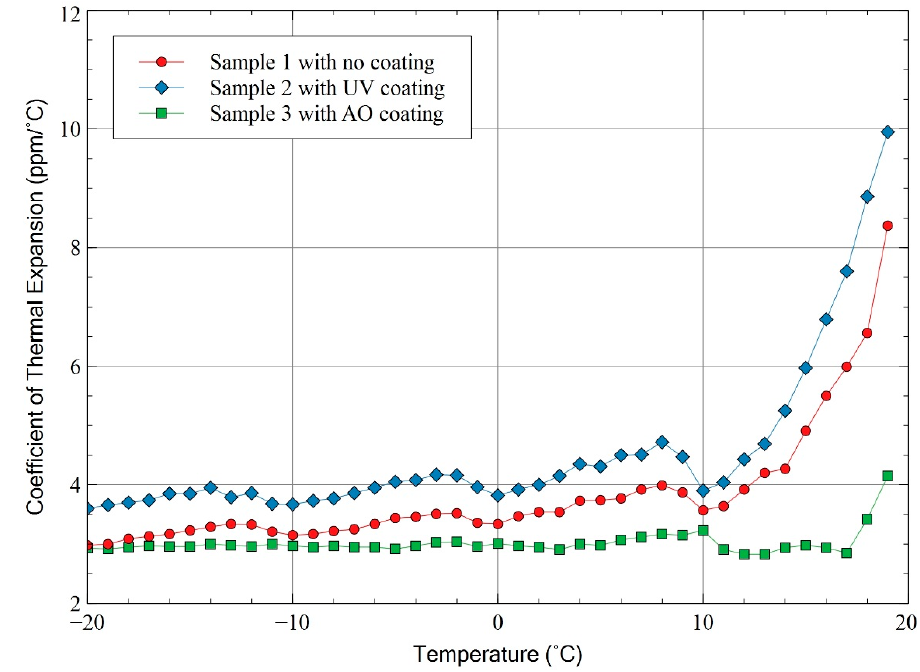
Figure 10. The overall result from the full system test. The CTE values for samples 1, 2 and 3 were compared with reference CTE data measured using Thermomechanical Analyzer (TMA).